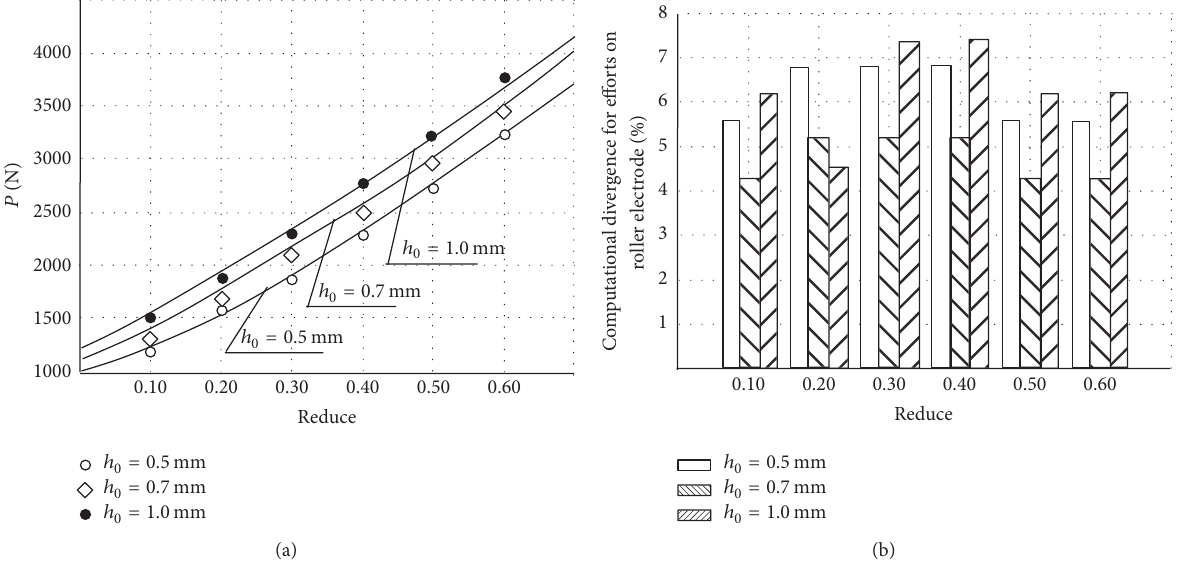
Figure 14: The calculated and the experimental distributions of the efforts on the roller electrode during the electric contact surfacing by the compact material. R1 = 50 mm; a 1 = 0.124; a 2 = 0.052; a 3 = − 3.70; 𝜎 𝜏0 = 60.1 N/mm 2 ; 𝜆 = 0.26 .